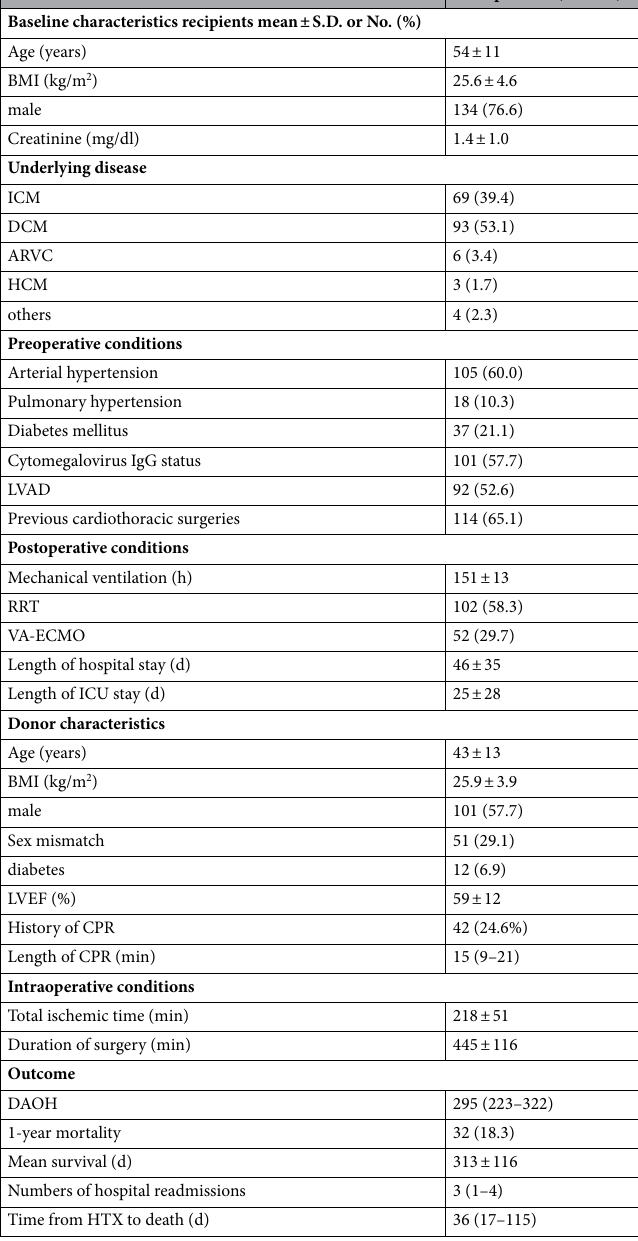
Table 1. Characteristics of HTX recipients and donors. BMI Body mass index, ICM ischemic cardiomyopathy, DCM dilated cardiomyopathy, ARVC arrhythmogenic right ventricular cardiomyopathy, HCM hypertrophic cardiomyopathy, LVAD left ventricular assist device, RRT renal replacement therapy, VA-ECMO veno-arterial extracorporeal membrane oxygenation, DAOH days alive and out of